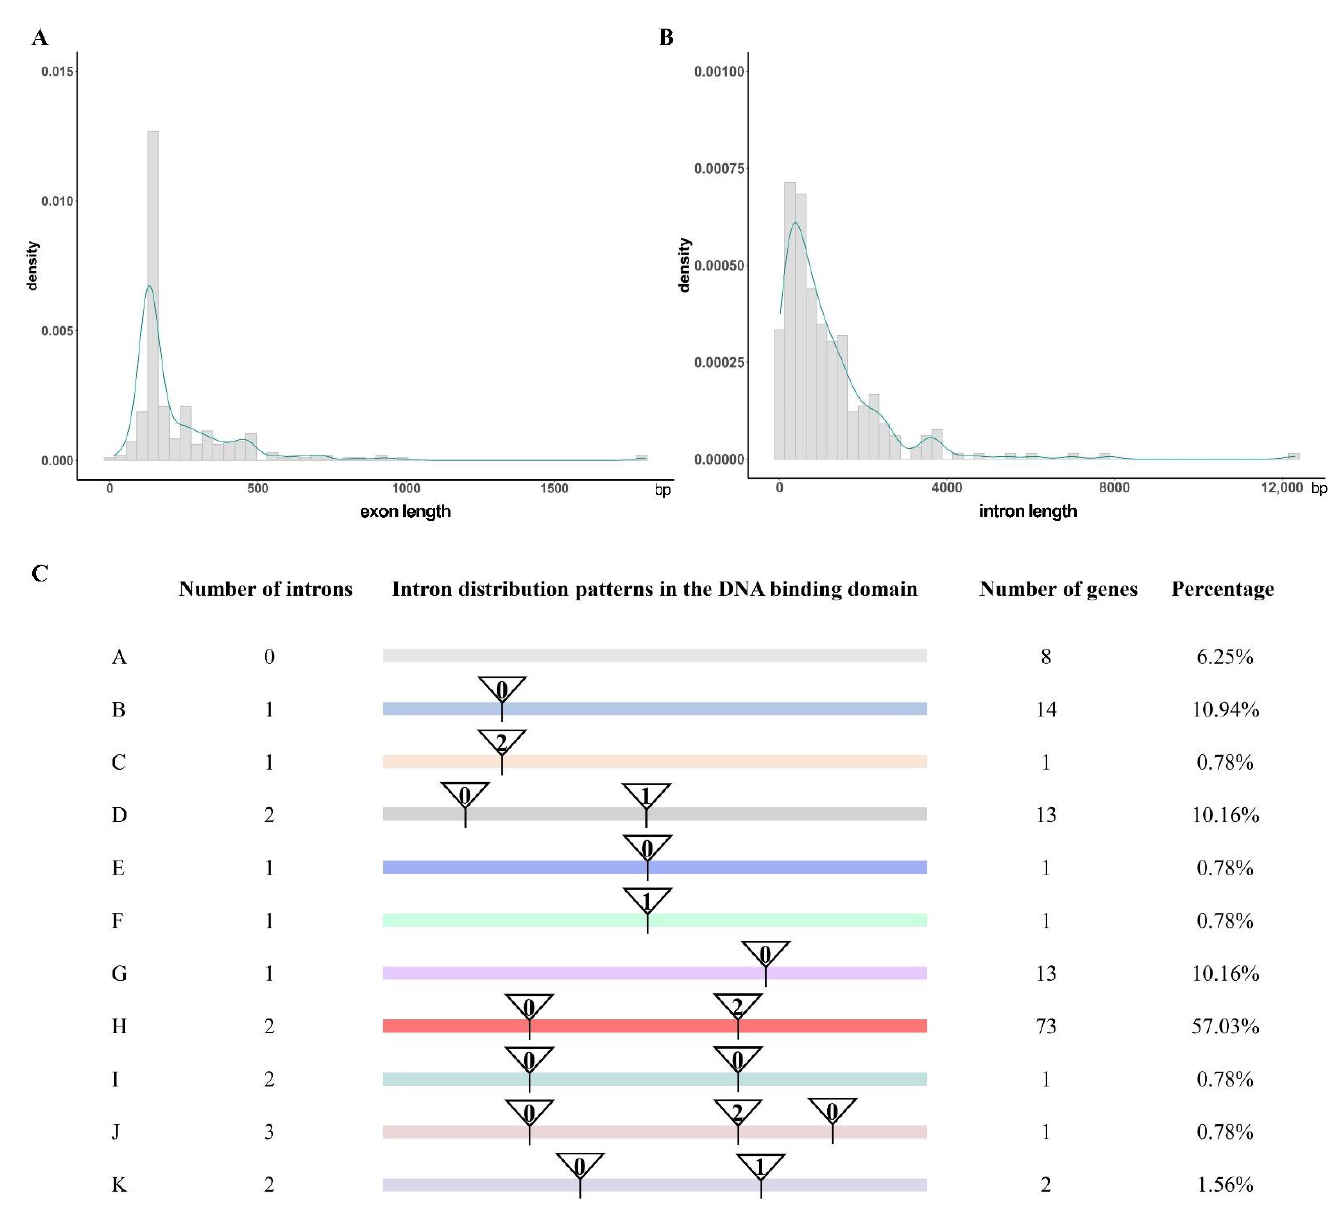
Figure 2. Distribution of exon length, distribution of intron length, and distribution patterns of introns in the DNA binding domain of CoR2R3-MYBs . ( A ) Distribution of exon length. ( B ) Distribution of intron length. The green line is the density of the distribution. ( C ) A total of 11 distribution patterns, named A to K. Triangles and numbers represent the positions and splicing phases of introns (0, phase 0; 1, phase 1; 2, phase 2), respectively. The horizontal bars in different colors represent the MYB DNA-binding domain in different patterns. The number of introns in each pattern is shown on the left. The number and percentage of CoMYBs in each pattern are shown on the right.